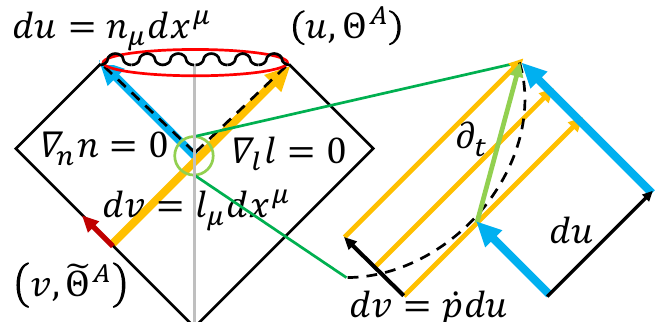
Figure 1 . Penrose-like diagram for the double null foliation ( u, v ) , with left and right parts representing hypersurfaces along incoming and outgoing directions respectively. The blue and yellow arrows represent the congruence of u and v , while the green arrow being the gradient along the tangent vector ∂ t underlying the ray tracing function v = p ( u ) . Notice that du is already living on the same slice as dv